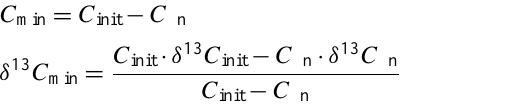
Table 1) that no realistic isotope signatures for the miner- alized fraction were obtained. For the series that were re- tained ( n = 19), the standard error on the isotopic signature of the mineralized DOC was on average 4 . 3 ± 1 . 7 ‰, based on standard error propagation methods of the uncertainty on the measurements. Statistical tests were performed in R. The non-parametric paired Wilcoxon signed rank test was applied to test for dif- ferences in concentration or isotope values at different times throughout the incubation series. Average values are given ± the standard deviation. The robust linear regression was done by using an M-estimator (R-package: